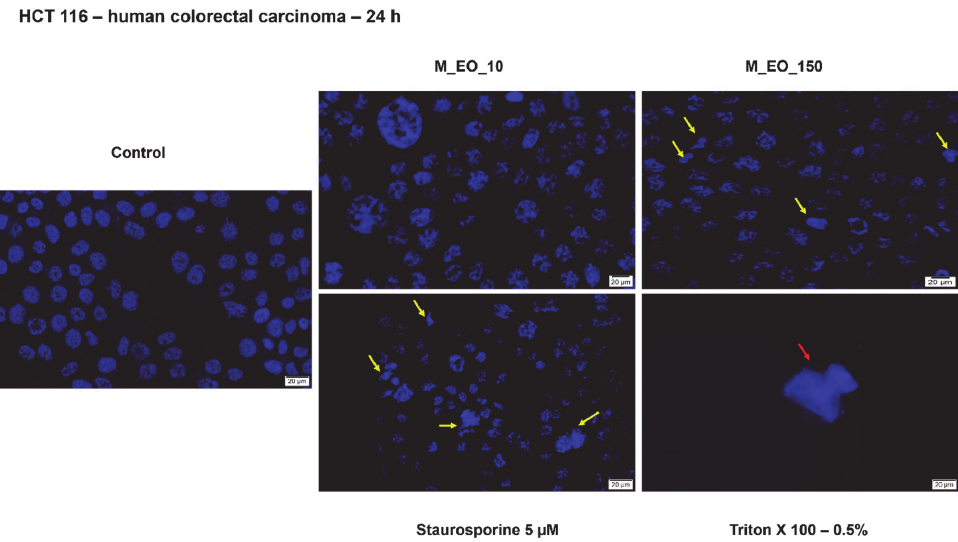
Figure 3 . Colorectal cancer cells—HCT 116 nuclei stained with Hoechst 33342 dye after a 24 h treatment with Mentha piperita L. essential oil—M_EO (10 and 150 μ g/mL). Staurosporine (5 μ M) was used as the positive control for apoptotic changes at nuclear level and Triton X ‐ 100 (0.5%) for necrosis. The yellow arrows indicate signs of apoptosis, and the red arrow shows signs of necrosis. The scale bar was 20 μ m.